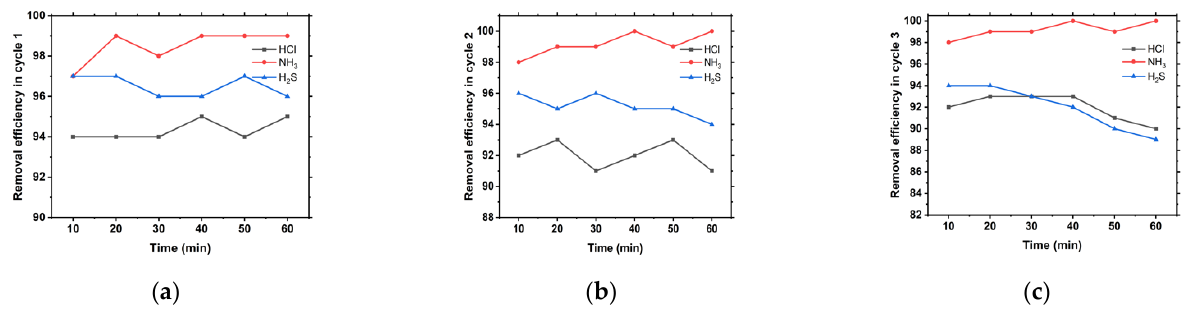
Figure 5. The contaminant removal efficiency in the carbonation stage at 680 °C for the first ( a ), the second ( b ), and the third cycle ( c ).